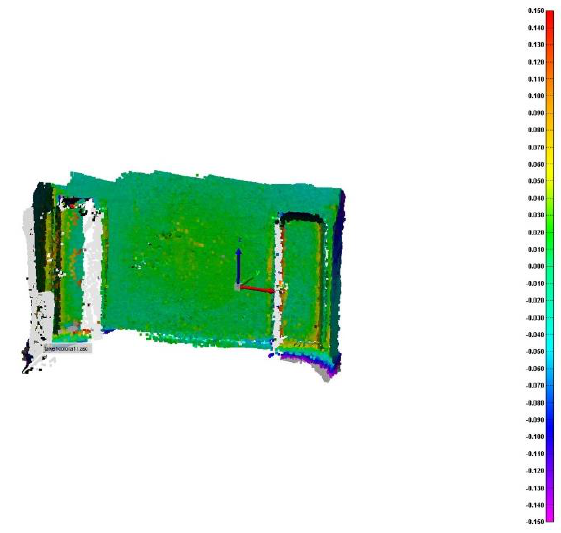
Figure 8 Deviation Map between Faro laser scanner and the proposed system (scale in meters)